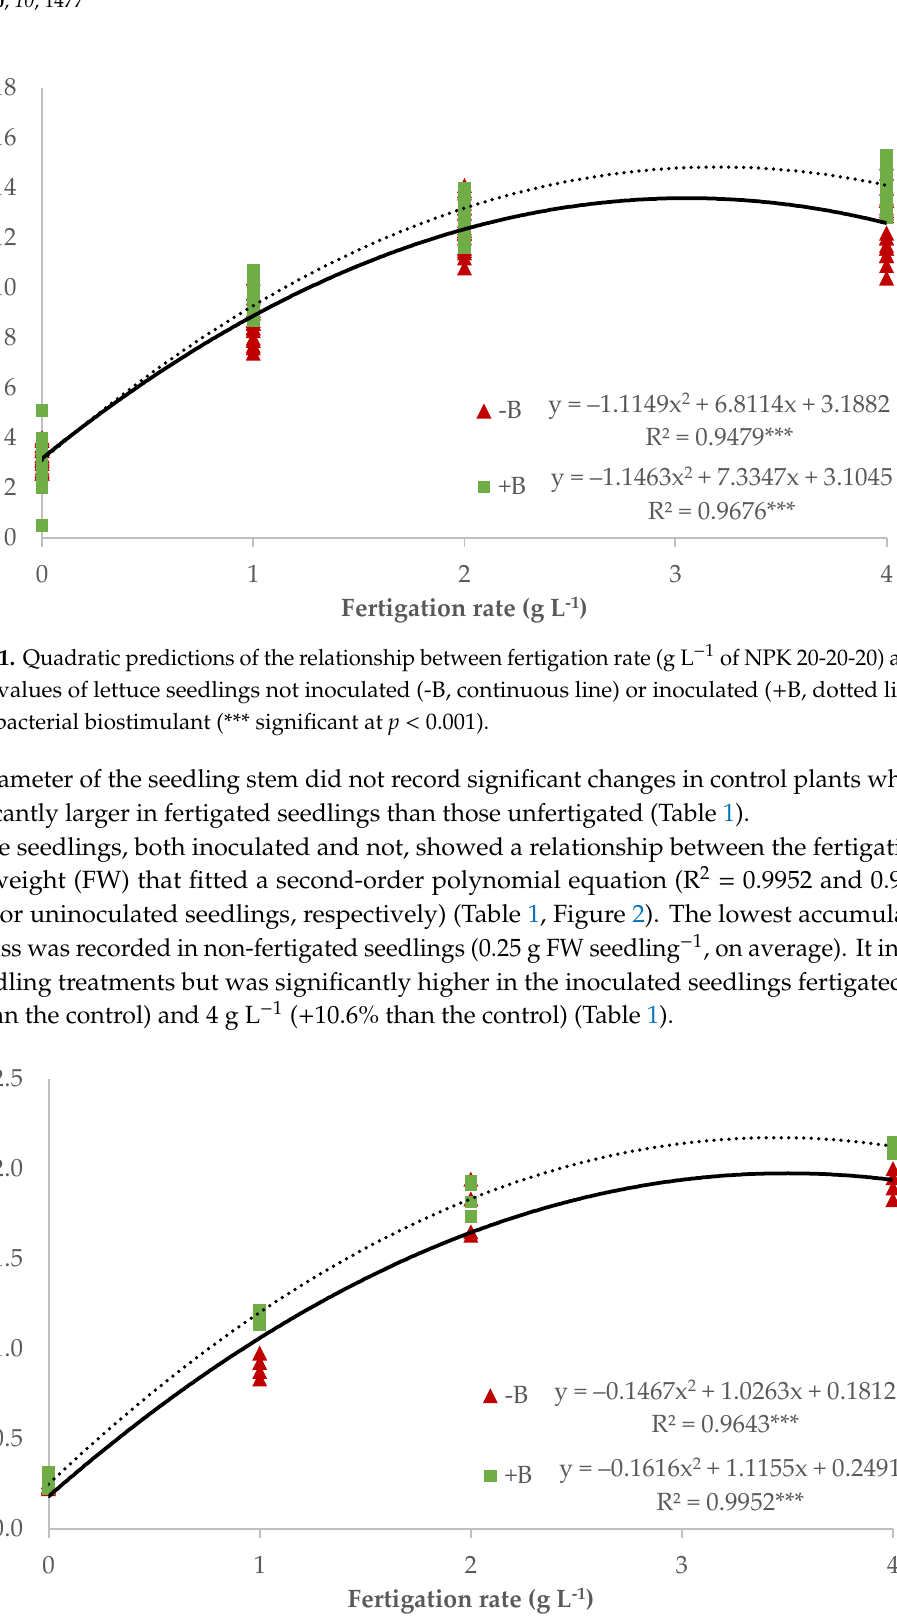
Figure 2. Quadratic predictions of the relationship between fertigation rate (g L − 1 of NPK 20-20-20) and fresh weight values of lettuce seedlings not inoculated (-B, continuous line) or inoculated (+B, dotted line) with a bacterial biostimulant (*** significant at p < 0.001).